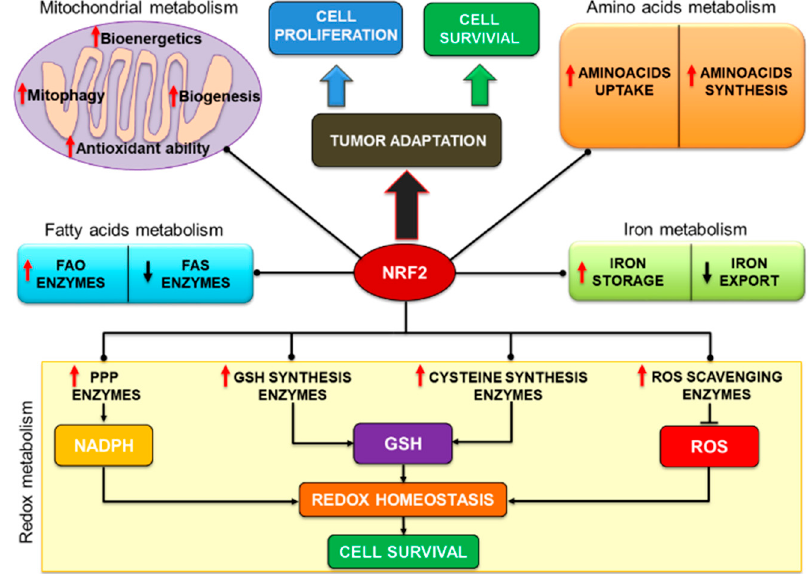
Figure 3. NRF2 regulates the multiple metabolic pathways of malignant cells. NRF2 transcriptionally controls the expression of genes controlling the expression of direct or indirect modulators of cancer metabolism, ultimately promoting tumor adaptation, cell proliferation and cell survival. List of abbreviations: FAO: Fatty acids oxidation; FAS: Fatty acids synthesis; NADPH: Reduced form of nicotinamide adenine dinucleotide phosphate; GSH: Reduced form of glutathione; ROS: Reactive oxygen species.